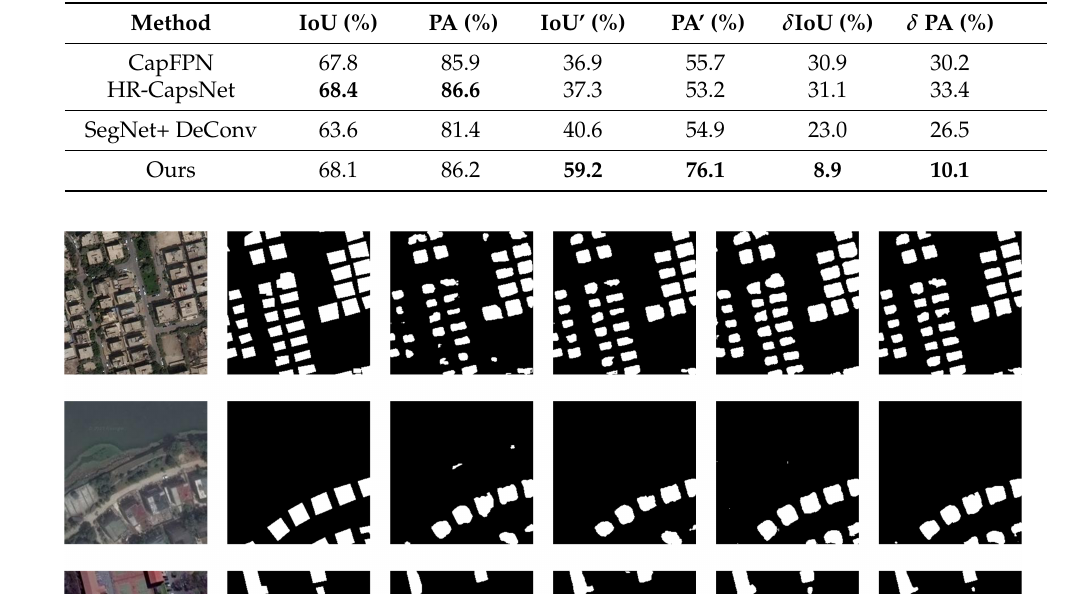
Table 6. Performance of different building extraction methods on the WHU dataset and Yellow River dataset (WHU dataset as source domain).